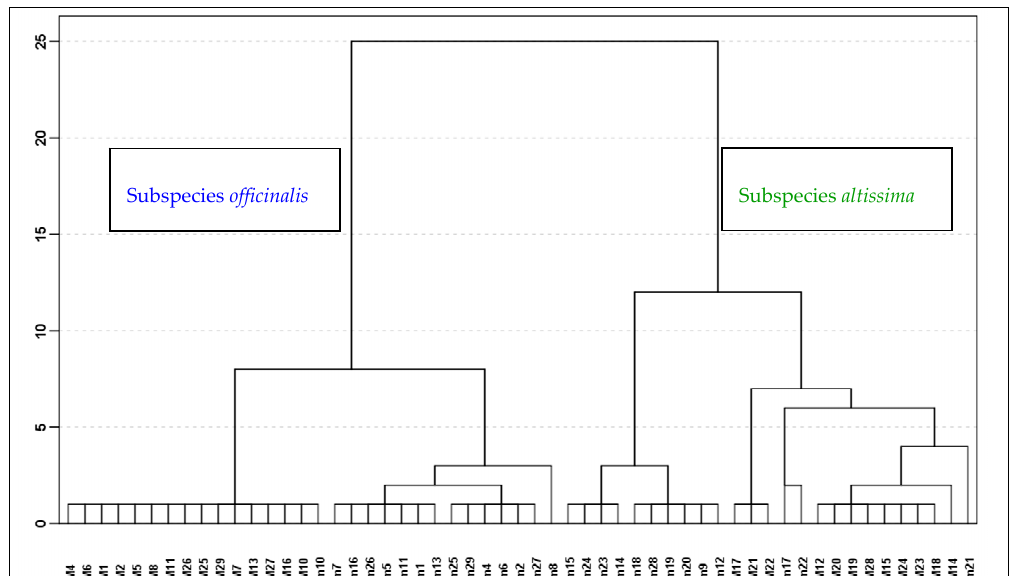
Figure 1. Dendrogram showing the similarities between the leaf oils of the accessions of Melissa offcinalis . (m1–m29: samples of the first cut, M1–M29: samples of the second cut).